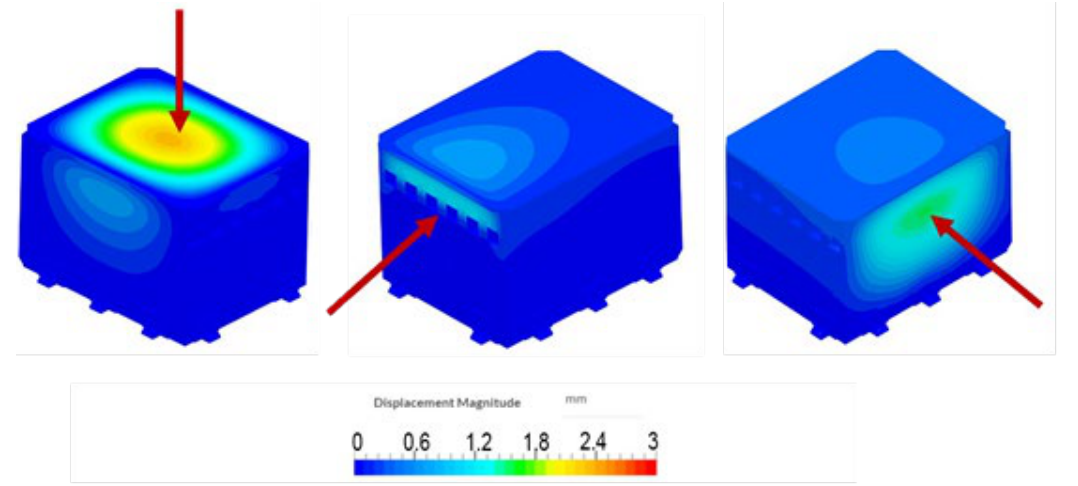
Figure 14. Total deformation for accumulator container (mm).